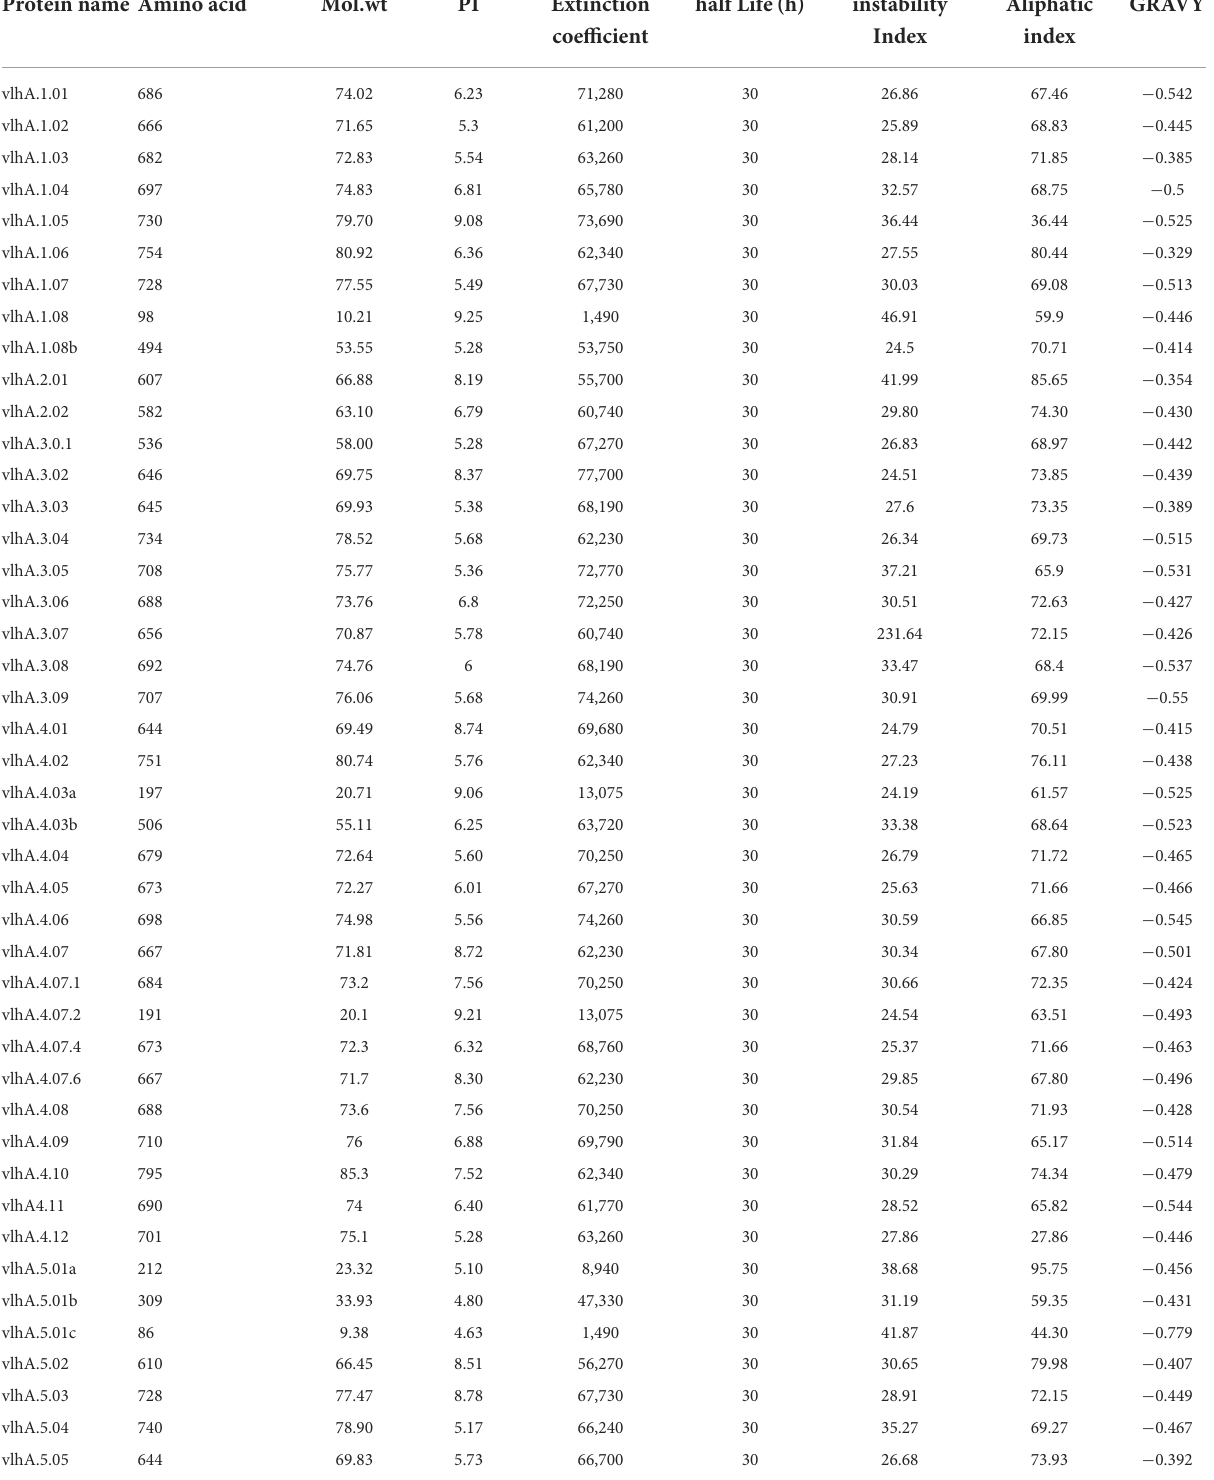
TABLE 3 Physiochemical properties like number of amino acids, molecular weight, isoelectric point, extinction coeffcient, half-life (h), instability index, aliphatic index, and GRAVY of M. gallisepticum vlhA